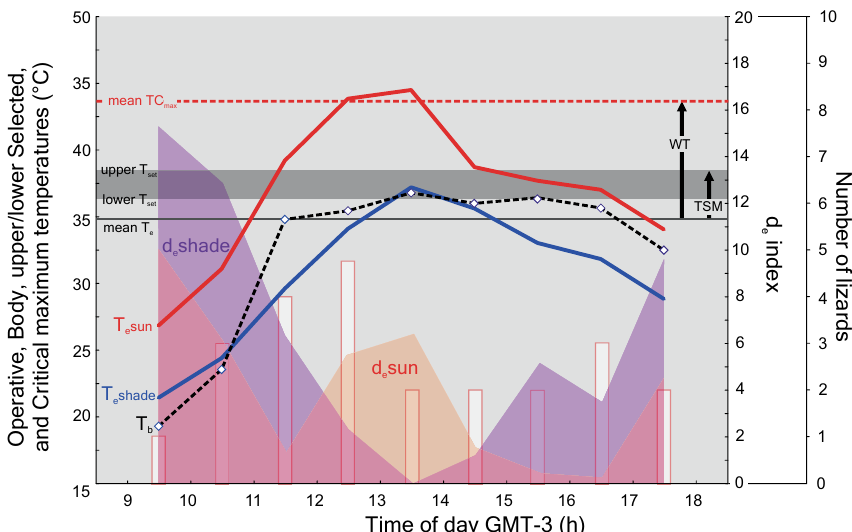
Figure 2. Variation during the activity of the mean operative temperatures obtained from open (°C, T e -sun: red solid line) and shaded (°C, T e -shade: blue solid line) habitats, and the mean body temperature (°C, T b : black dashed line with white diamonds—blue foreground) of Liolaemus montanezi . Mean operative temperatures (°C, T e : grey straight line), and critical thermal maximum (°C, CT max : dashed straight red line). The grey vanished area represents the set-point range of the preferred body temperature in laboratory (°C, upper and lower T set ). The warming tolerance (WT) and the thermal safety margin for physiological performance (TSM) are indicated with arrows. The variation of the thermal quality during the activity calculated from open habitat (d e -sun index: faded red area) and shaded (d e -shade index: faded purple area) habitats are indicated in the Y-right axis. Number of lizards (faded white bars) are also indicated in the double Y-right